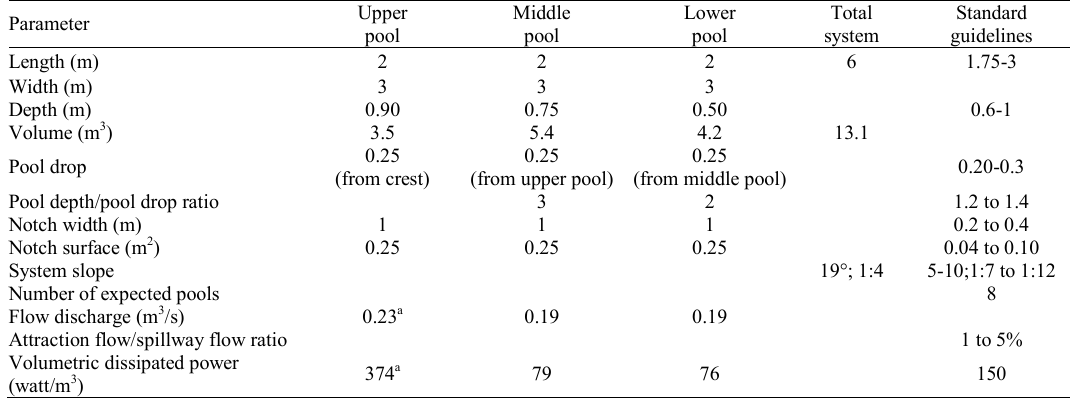
Table 1. General characteristics of pool and weir systems at the Route 28 dam and comparison with guidelines for standard systems. a Estimated for a water level of 20 cm over the